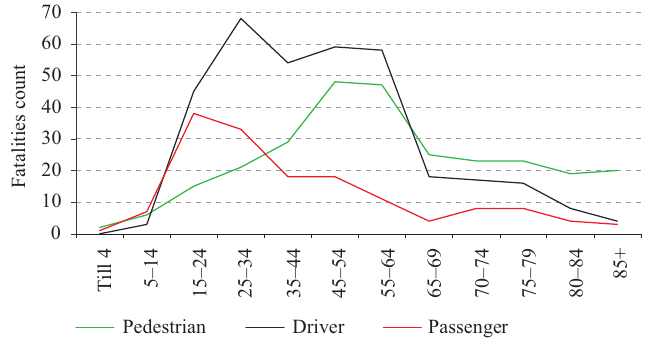
Figure 5. The distribution of road fatalities in line to the roles of road users on the streets and roads for the period